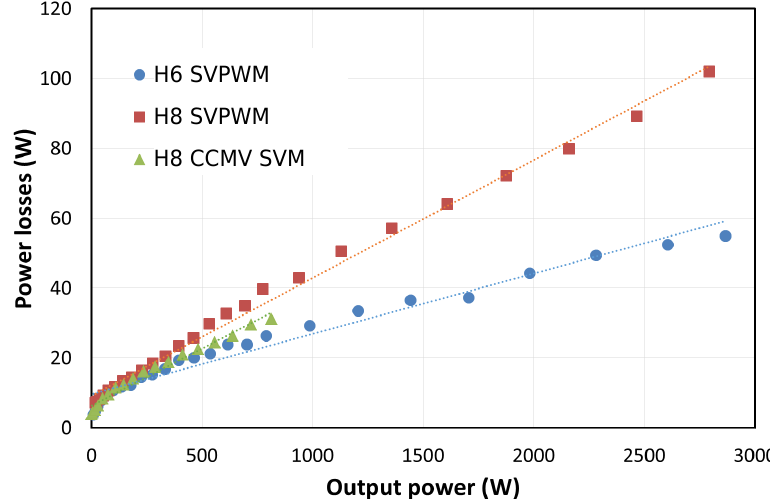
Figure 13. Power losses of silicon IGBTs versus output power [17].